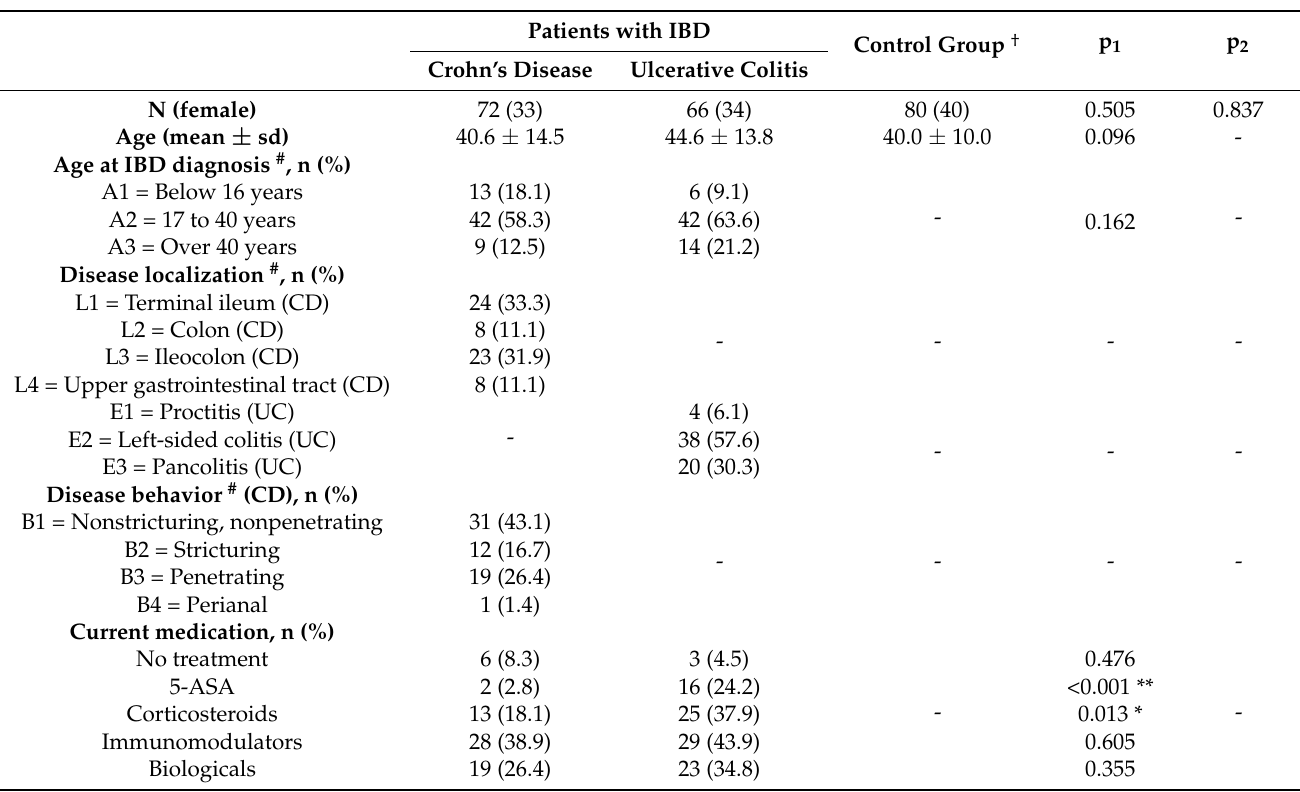
Table 1. Characteristics of patients and